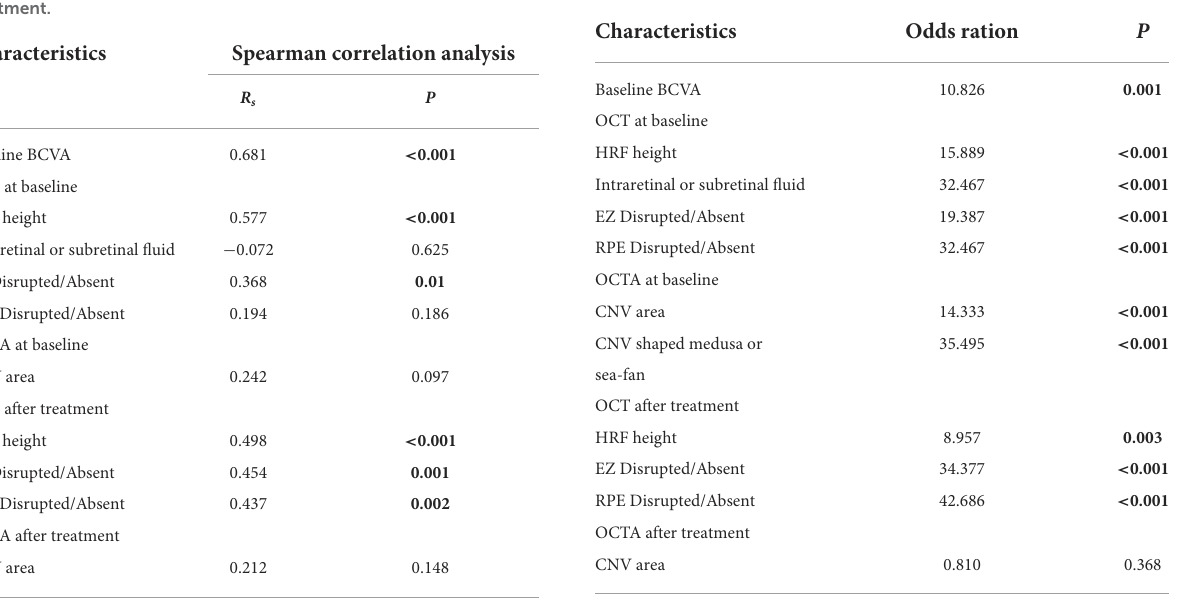
TABLE 5 Binary logistic regression analysis of variables associated with recurrence of